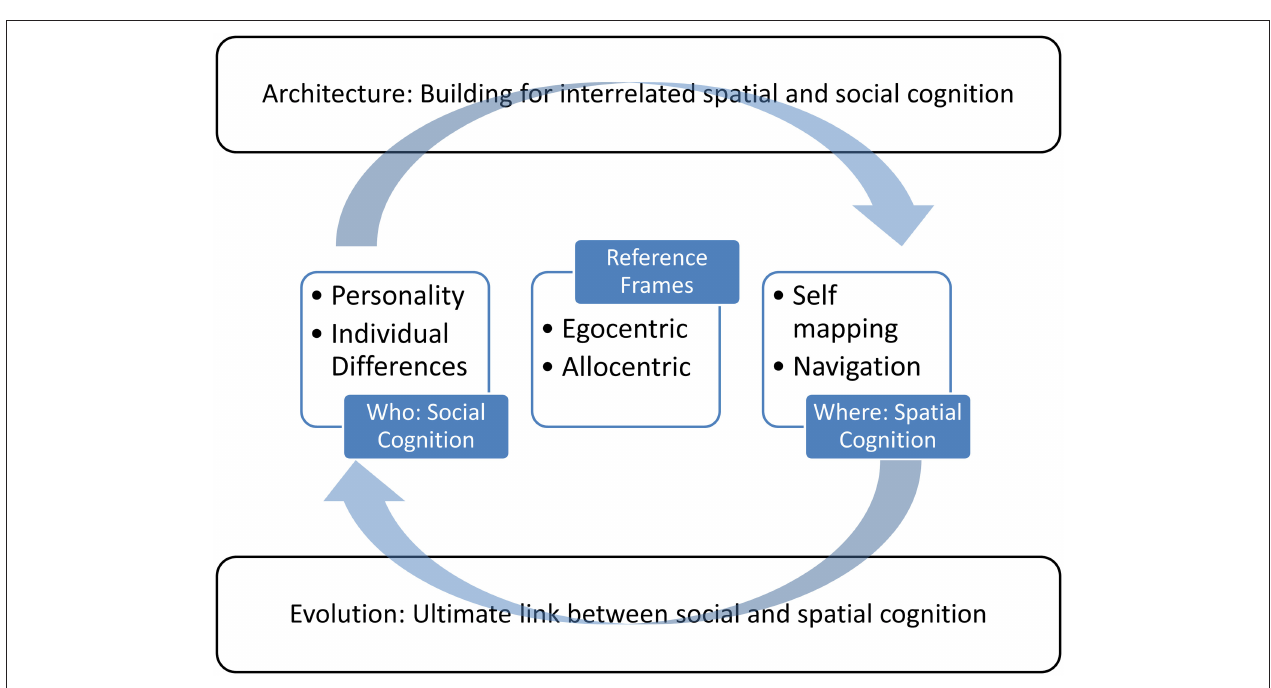
FIGURE 1 | An illustration of the approach taken in this review. Central to the review are the concepts of self and spatial cognition, which are connected by the consideration of egocentric and allocentric reference frames. These provide the context to move from a foundation in evolutionary theory to applications for the built